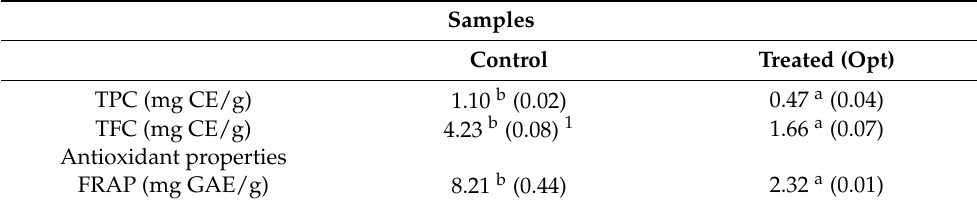
Table 5. Total phenolic content, total flavonoid content, and antioxidant property of extracts of cowpea processed at optimized